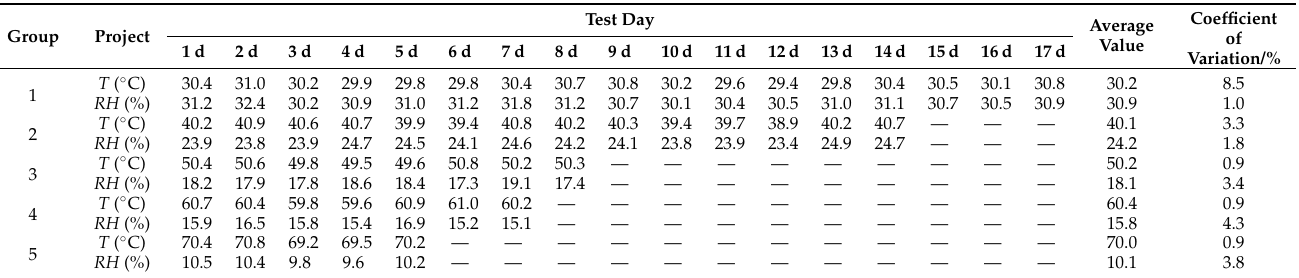
Table 2. Daily temperature and relative humidity in the box.